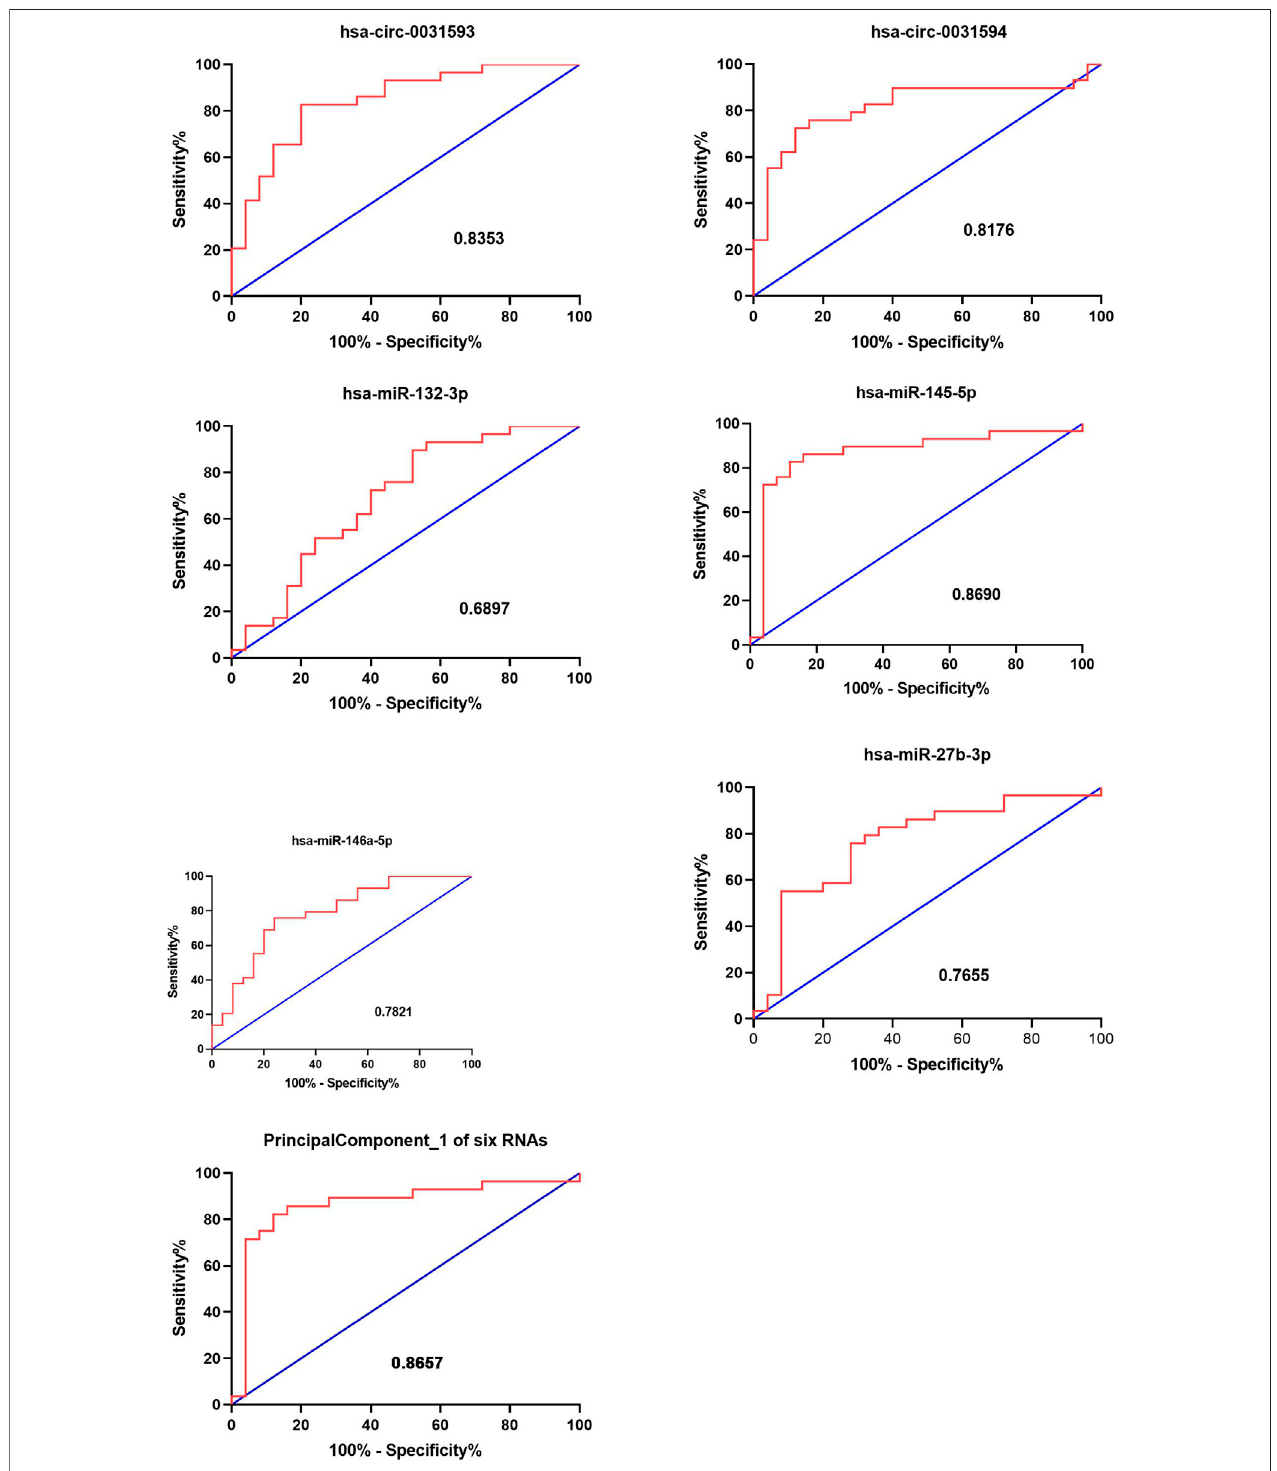
FIGURE 9 | Functional value of circRNAs and miRNAs. The receiver operating characteristic (ROC) curve analysis for the function of CRSwNP. The ROC curve analysis of hsa-circ-0031593, hsa-circ-0031594, hsa-miR-132-3p, hsa-miR-145-5p, hsa-miR-146a-5p, and hsa-miR-27b-3p and principal component 1 of these six ncRNAs for the signi fi cance in the occurrence and development of CRSwNP. The AUC (area under curves) values are given on the graphs.